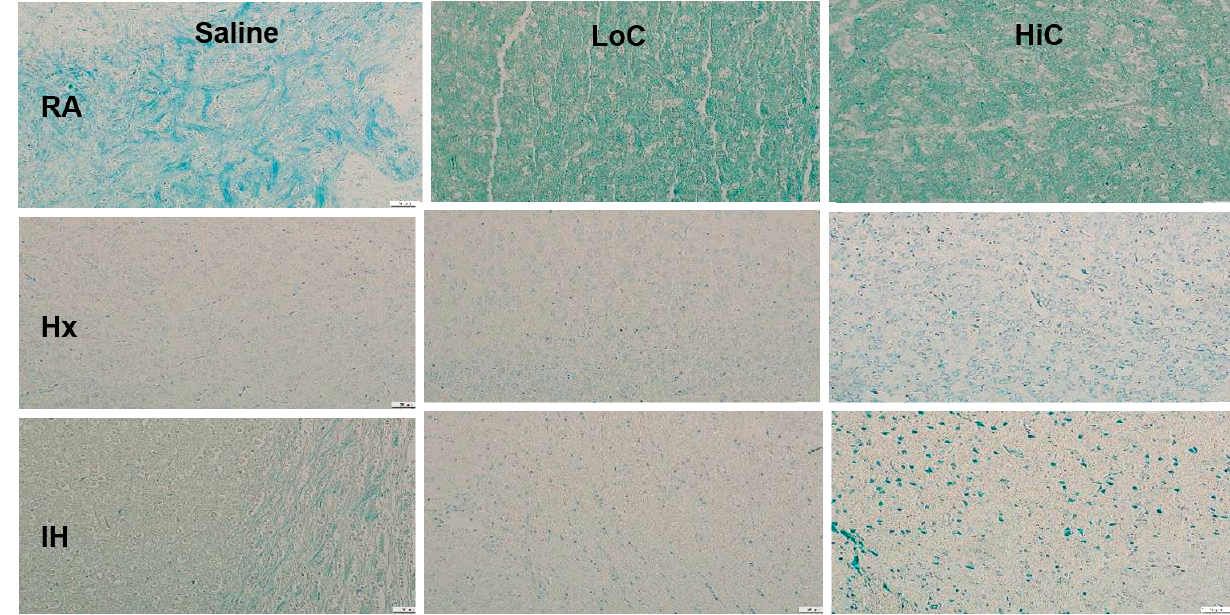
Figure 10. Representative Luxol fast blue staining of myelinated neurons in the cerebral cortex at P14. Groups are as described in Figure 1. Images are 20 × magnification, bar scale is 50 µ m. Both caffeine doses induced myelination in RA. Hx and neonatal IH suppressed myelination. Treatment with HiC in Hx and neonatal IH mildly increased myelination.